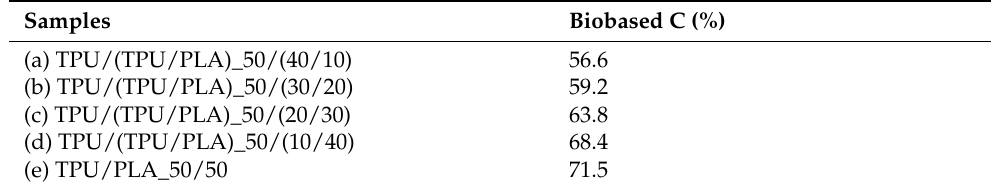
Table 2. Biobased carbon contents of TPU/(TPU/PLA) and TPU/PLA side-by-side bicomponent fibers.